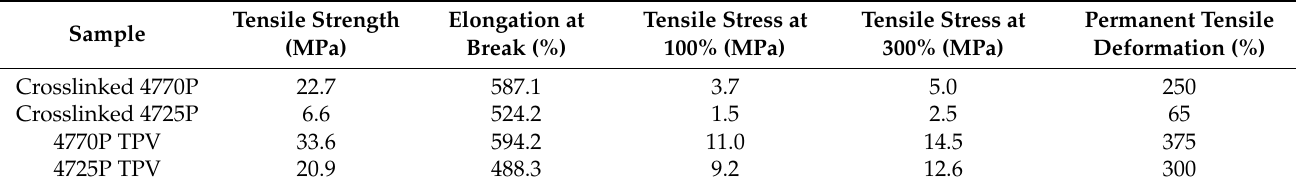
Table 5. Mechanical property data of the crosslinked EPDMs and TPVs.